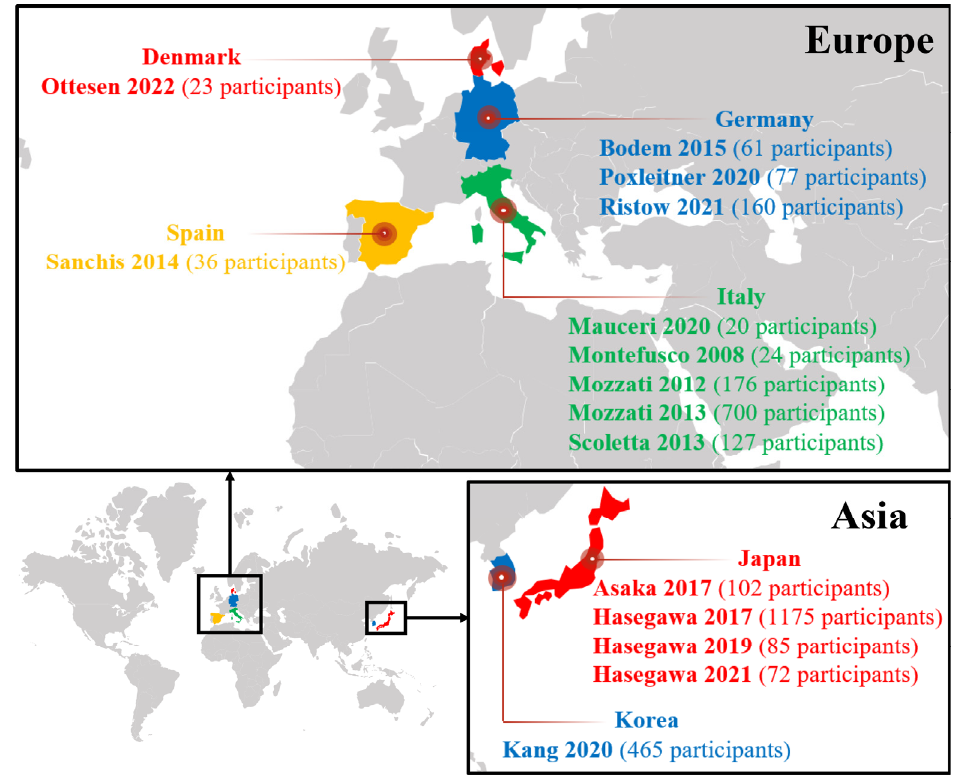
Figure 3. Evidence map of primary studies (regional profile) [27–40].